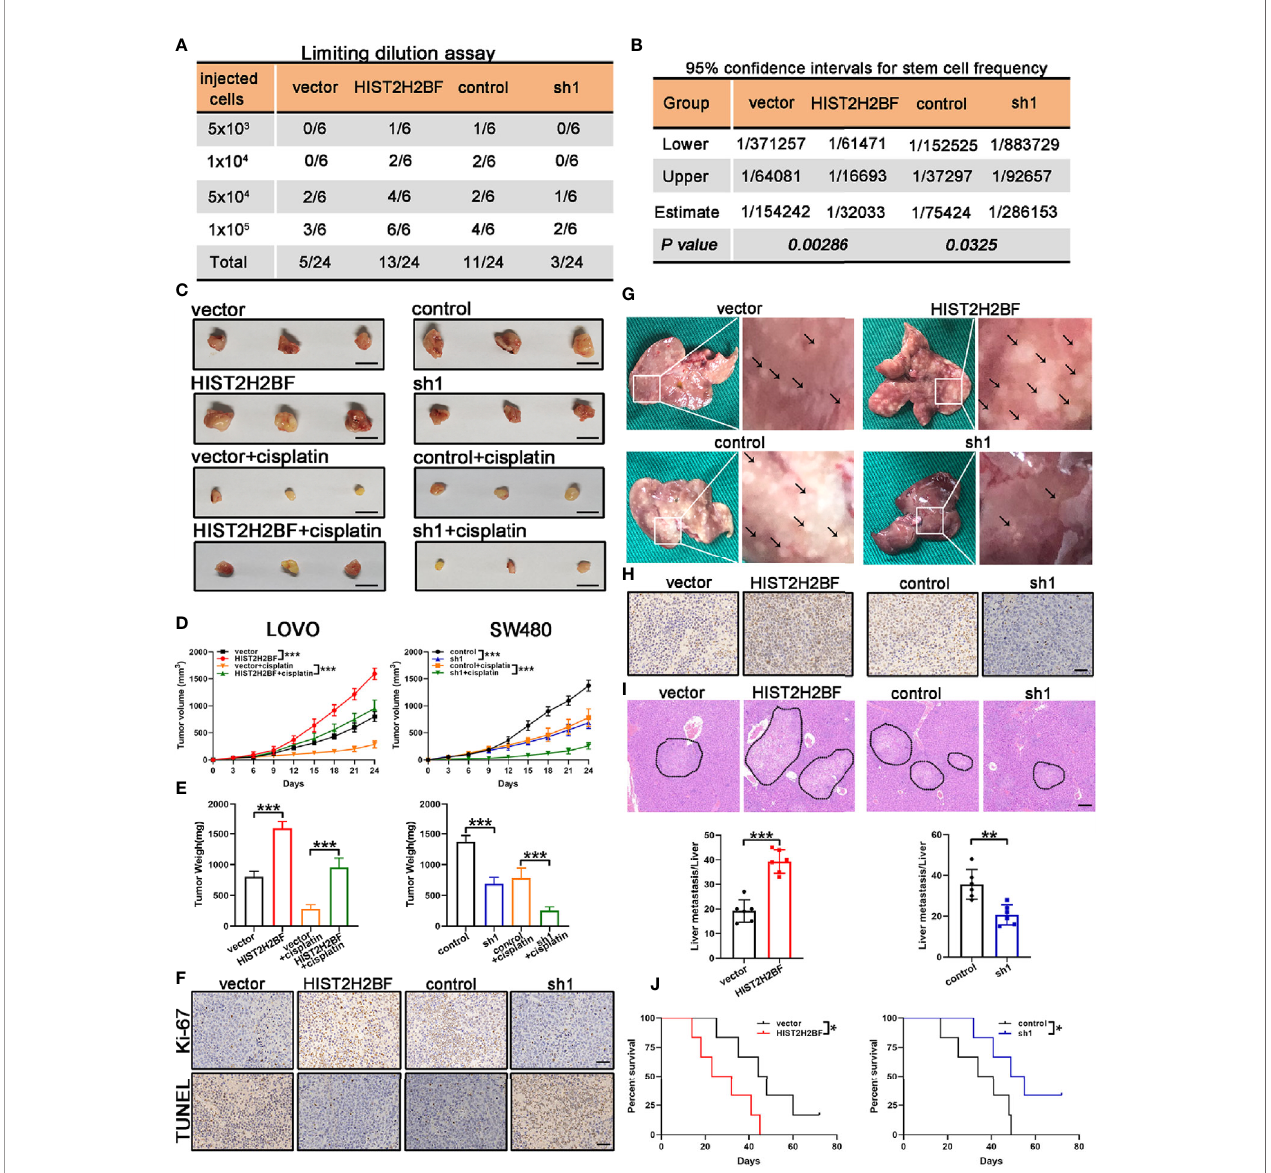
FIGURE 5 | HIST2H2BF promoted tumor initiation, self-renewal, and liver metastasis in mice. (A) LOVO and SW480 cells transfected with lentivirus HIST2H2BF or shHIST2H2BF were injected subcutaneously in nonobese diabetic/severe combined immunode fi ciency mice. The tumor-forming rates were determined 2 months post-injection. (B) The frequency of CSCs was obtained. (C) Tumors harvested from LOVO and SW480 cells, with or without cisplatin treatment. (D) Growth curves of LOVO and SW480 xenografts. Two-way ANOVA was employed to analyze the differences in tumor growth. (E) Tumor weight was weighted in LOVO and SW480 cells. (F) Ki-67 and TUNEL staining in the tumors harvested from LOVO and SW480 cells without cisplatin treatment. (G) Representative images of liver metastatic foci (marked by black arrowheads). (H) IHC staining for HIST2H2BF expression in the liver metastatic foci from LOVO and SW480 cells. (I) Hematoxylin and eosin (HE) of liver metastasis in the mouse model (upper panel). Scale bar, 200 m m. The number of liver metastatic foci were counted (lower panel). (J) OS of mice injected with LOVO and SW480 cells. *P < 0.05, **P < 0.01, ***P <